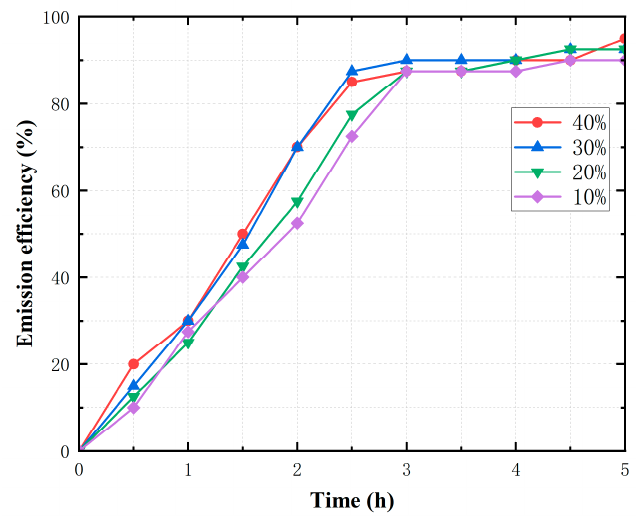
Figure 16. Emission effect curves of two inlet pipes, top sprayed